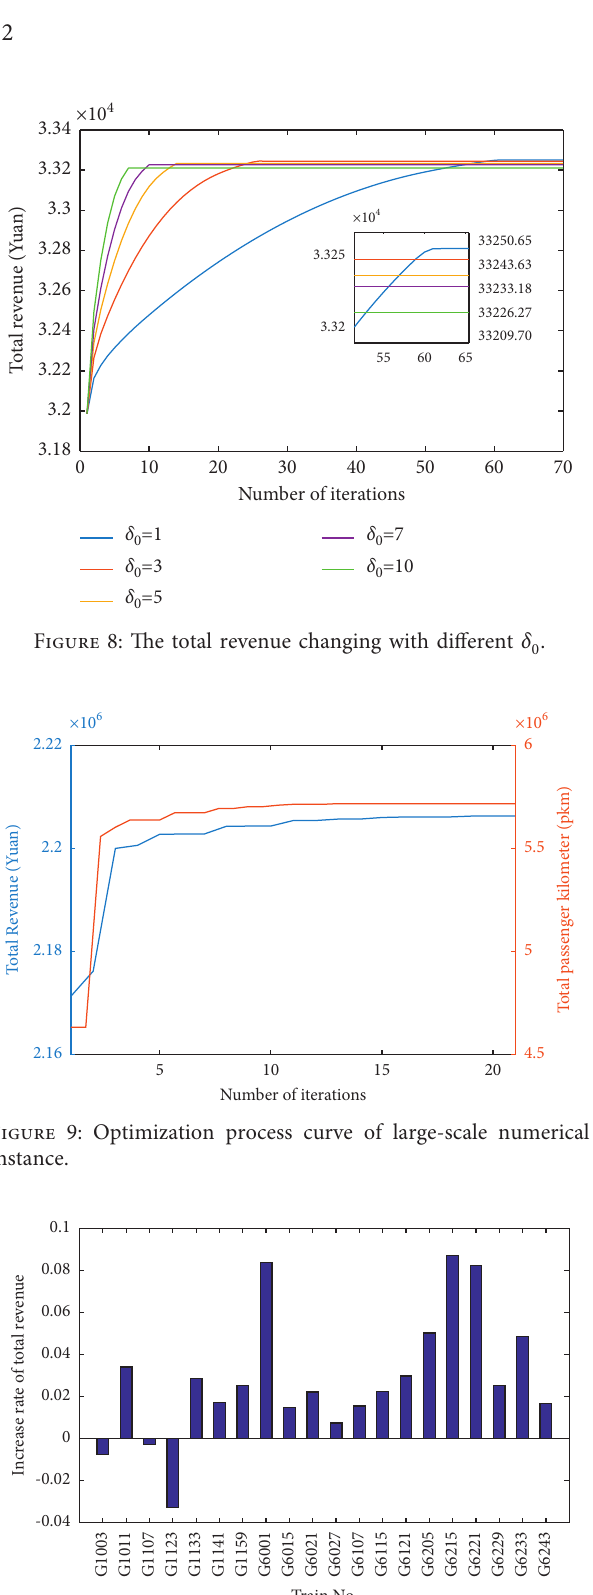
Figure 10: The comparison of each train’s revenue change rate.